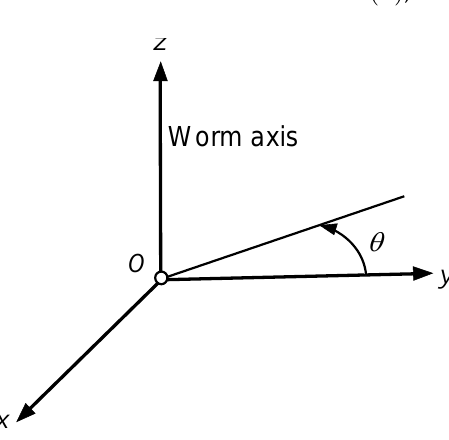
Figure 1. Coordinate system and worm axis.